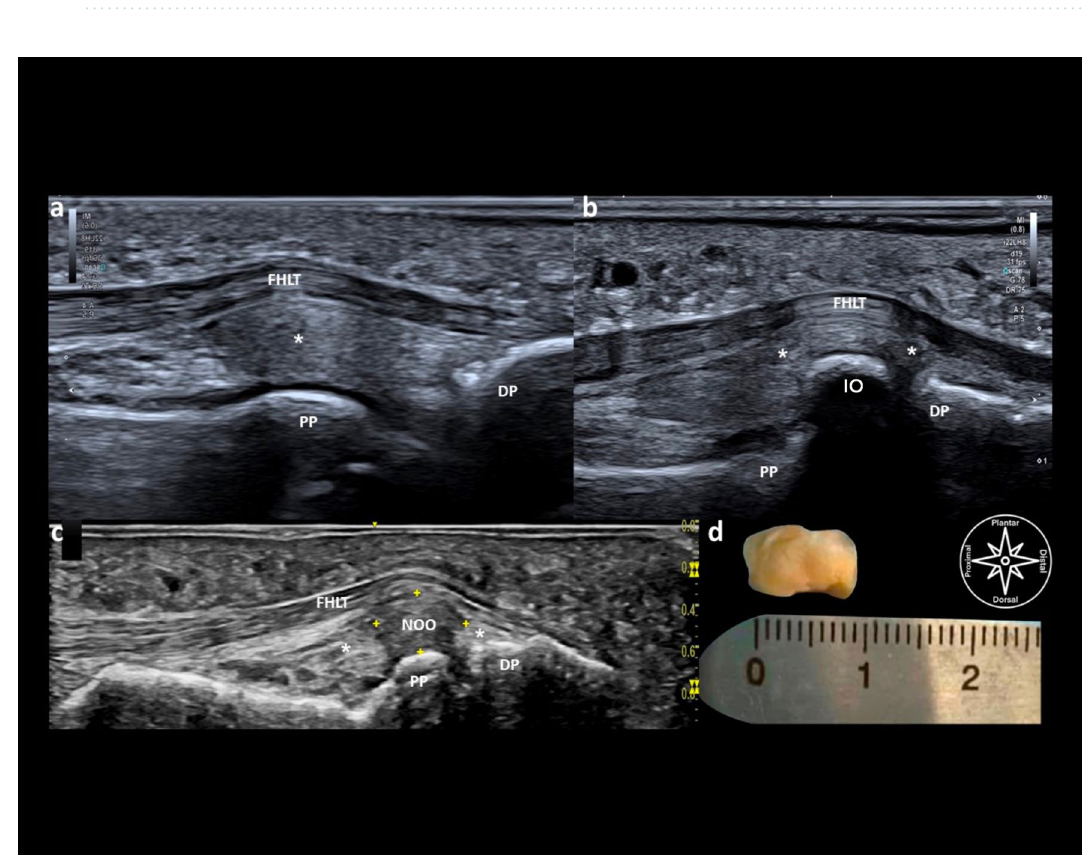
Figure 6. Diagnostic ultrasound findings in different plantar interphalangeal joint aspects, sagittal scanning without an ossicle ( a ), with an ossified ossicle ( b ) with a non-ossified (fibrocartilage) ossicle ( c ), comparative view of an interphalangeal non-ossified ossicle via diagnostic ultrasound (long axis measure 9 mm) and via gross anatomy body-donor (sagittal measure 9 mm) ( d ): PP proximal phalanx, DP distal phalanx, IO interphalangeal ossicle, FHLT flexor hallucis longus tendon, asterix * plantar plate, NOO non-ossified